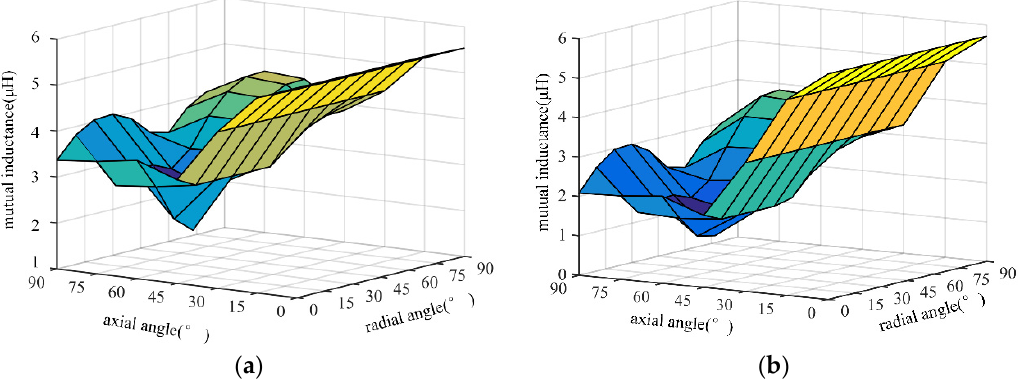
Figure 6. Mutual inductance when the receiving coil is in directional misalignment from: ( a ) Calculation with the proposed model; ( b ) measurement.